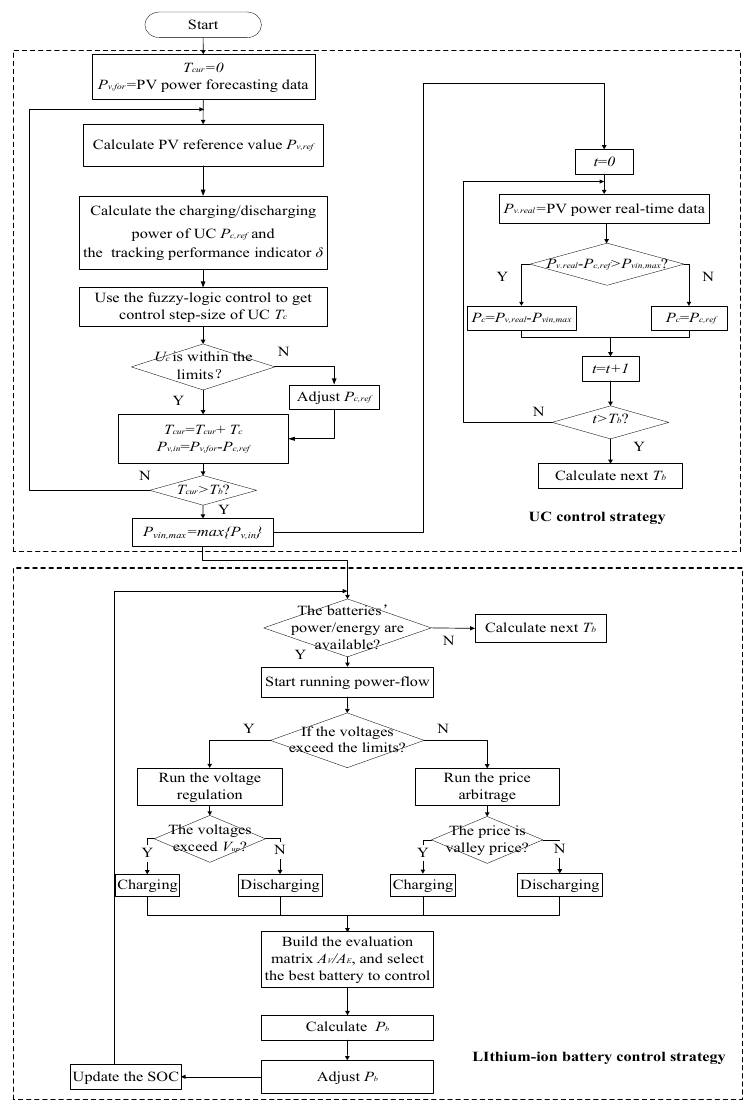
Figure 4. Flowchart of implementation of the